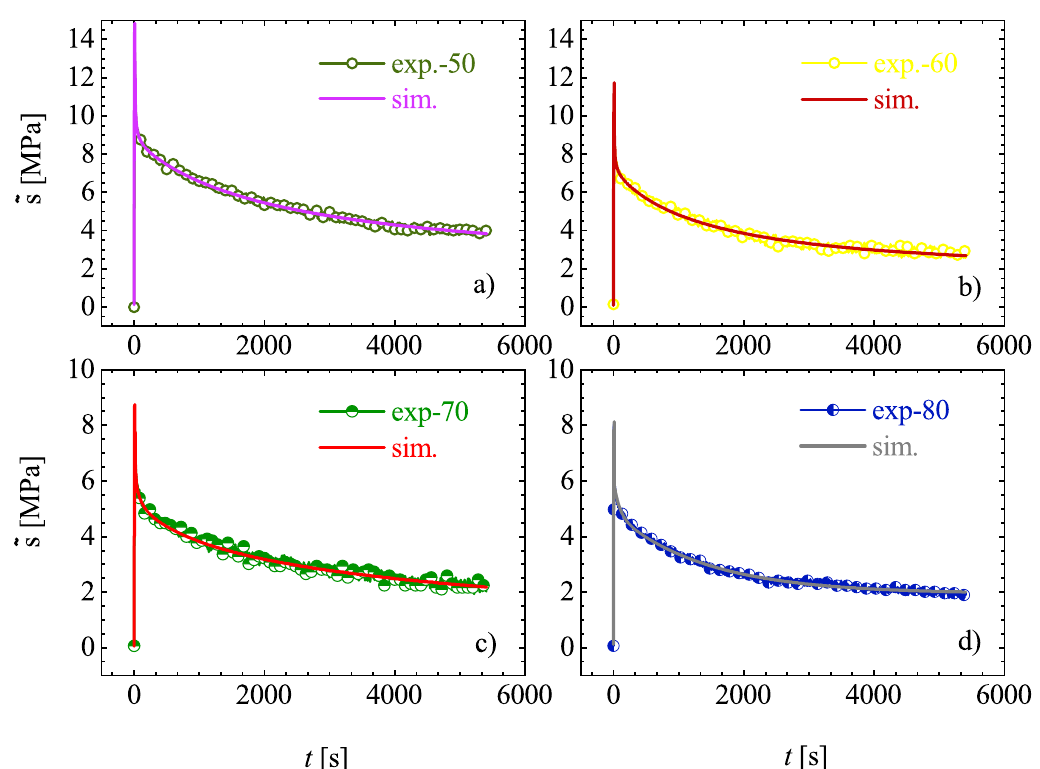
Figure 11. ( a – d ): Comparison of computational and experimental stress relaxation tests with different isothermal tempera- tures above θ g .